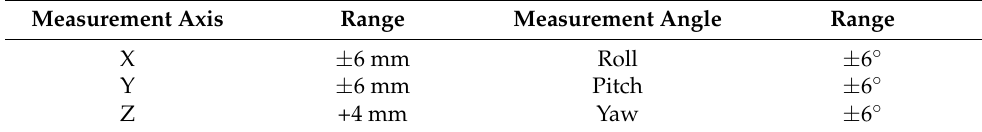
Table 1. Interface measurement ranges for